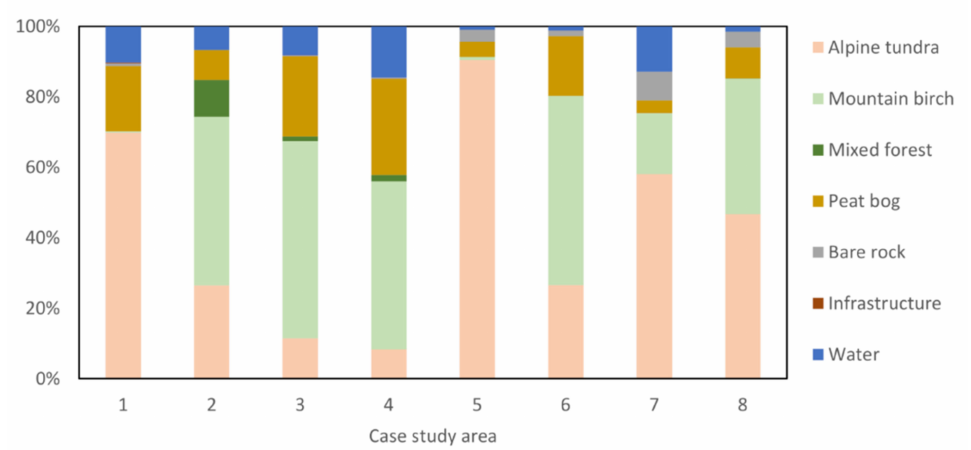
Figure 4. Landcover in each case study area (based on Corine Landcover data, NLS, CC-BY-4.0). (Illustration: Oula Seitsonen).